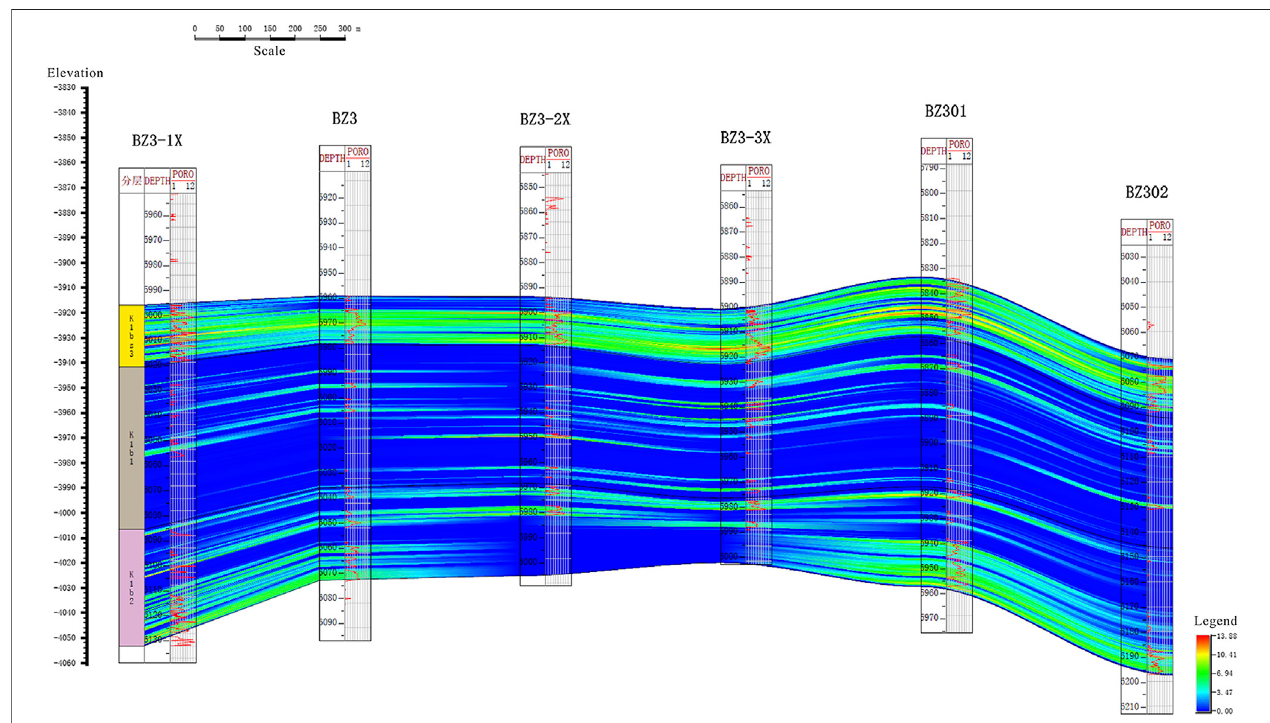
FIGURE 8 | Porosity pro fi le of Bozi 3 gas